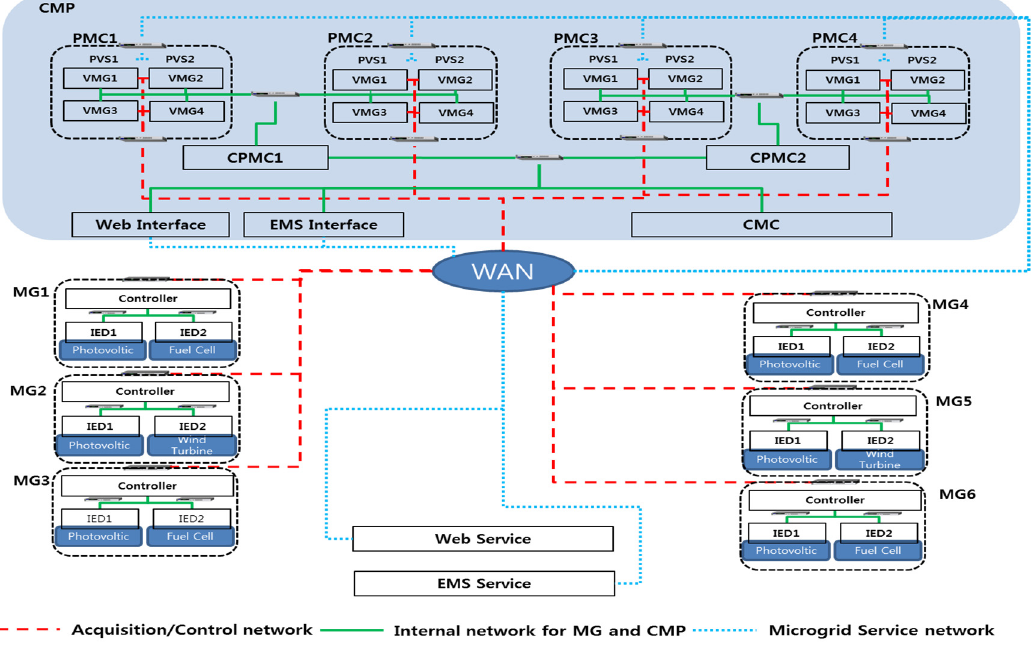
Figure 2. Proposed design system architecture of real-time cluster services.